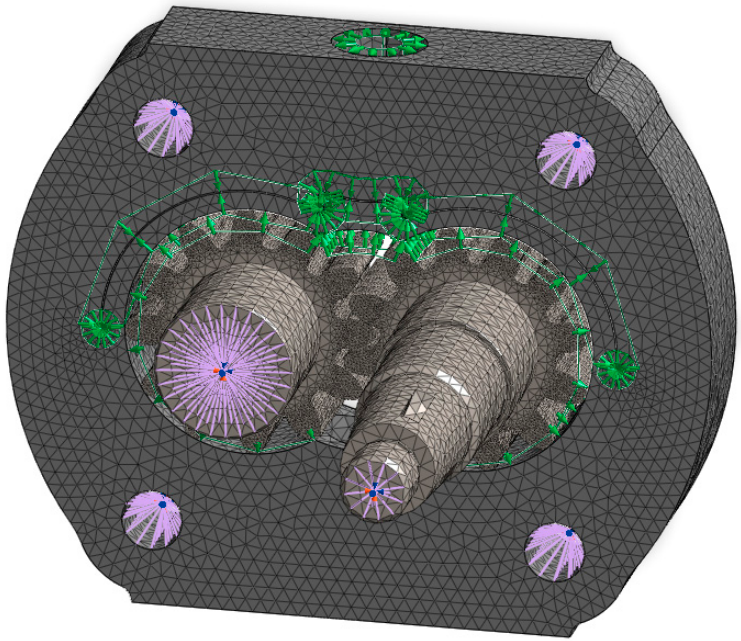
Figure 8. Discrete model, schematic representation of the loads and restraints.